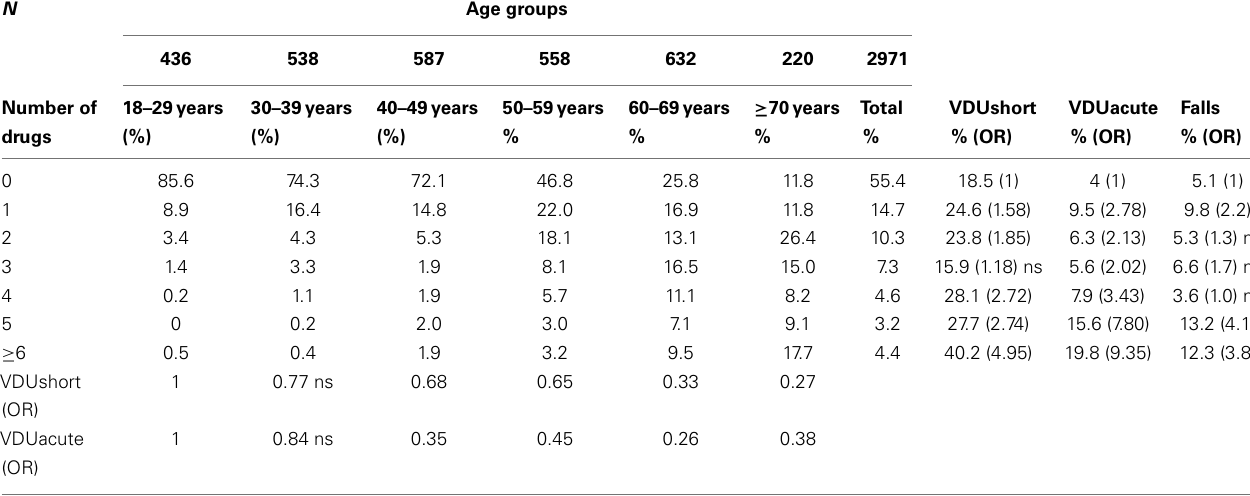
Table 4 | Number of drugs, age, andVDU.